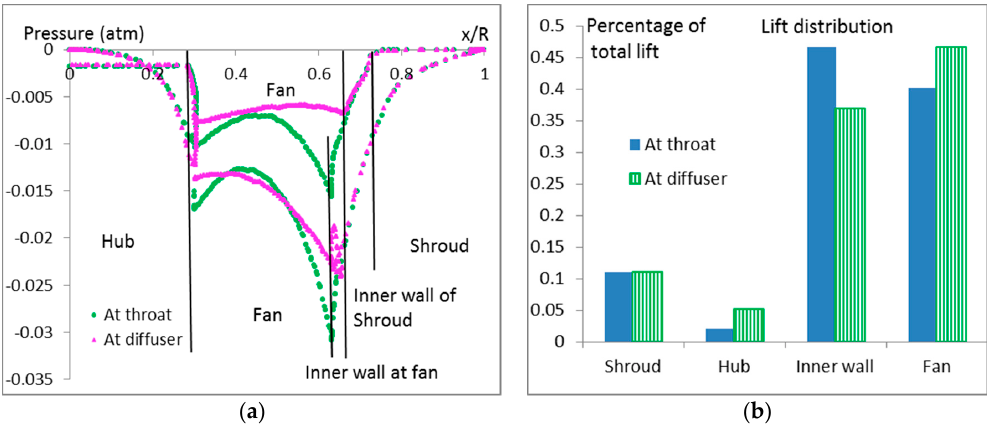
Figure 10. ( a ) Static pressure distribution on the surfaces of the aircraft in the central plane; ( b ) Lift distribution.